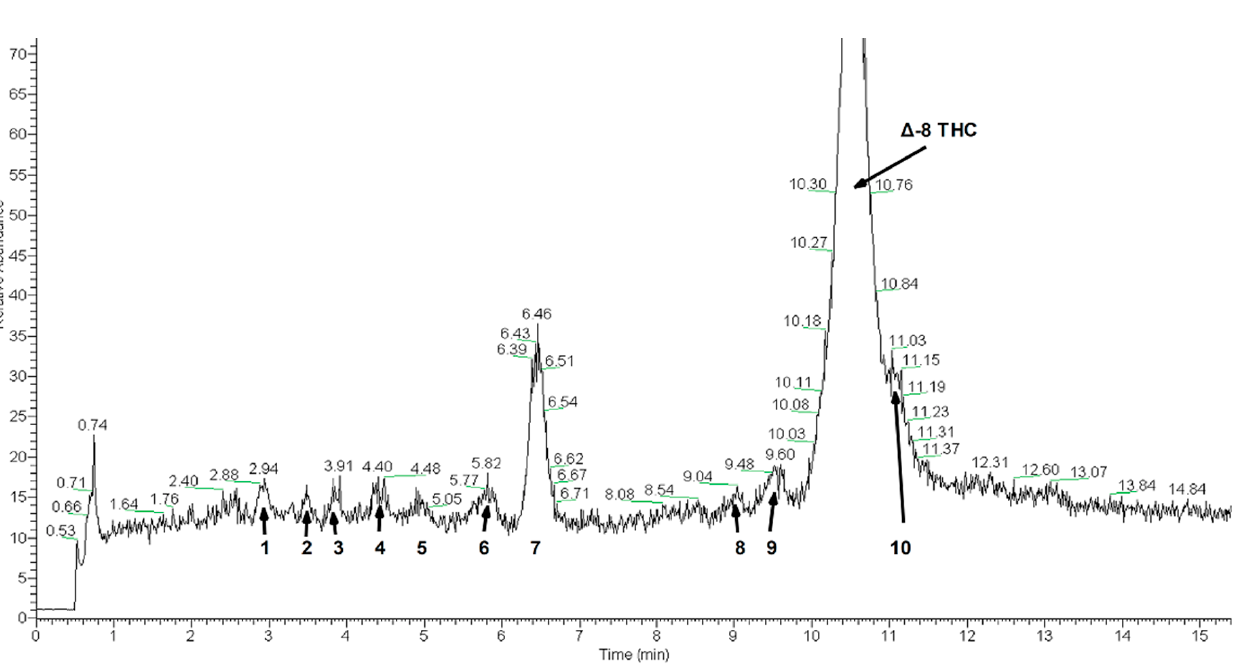
Figure 7. HPLC chromatogram of sample 6 performed during this study. A wavelength of 210 nm was used for the UV detector. The red triangles mark the range of a peak for integration.